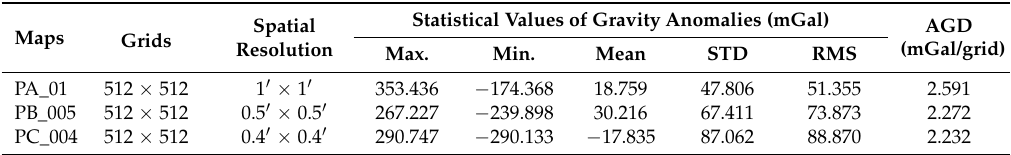
Table 1. Parameters of gravity maps PA_01, PB_005, and